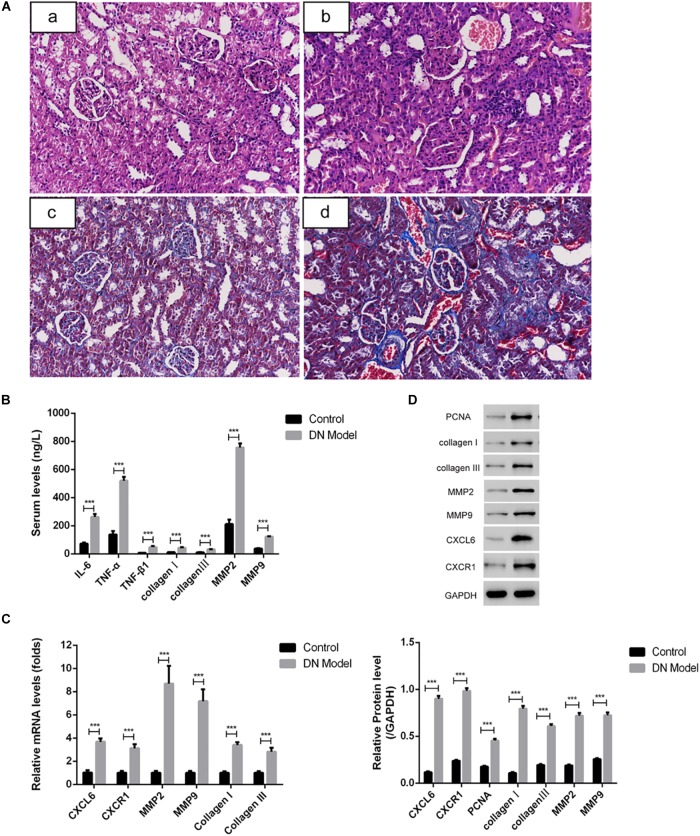
Fibrosis related cytokines in DN rat model. (A) H&E and Masson staining of renal tissues. (a) H&E staining of renal tissues in control group (b) H&E staining of renal tissues model group (c) masson staining of renal tissues in control group (d) masson staining of renal tissues model group (B) the levels of several fibrosis related cytokines in peripheral blood were measured by Elisa. (C) Relative mRNA expressions of several fibrosis related cytokines were determined by qRT-PCR (D) the protein levels of several fibrosis related cytokines were examined by Western blotting. ∗∗∗p < 0.001 vs. model group.